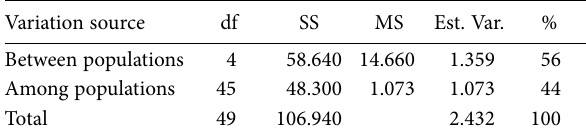
Table 6. Genetic variation within Diplodia sapinea populations.